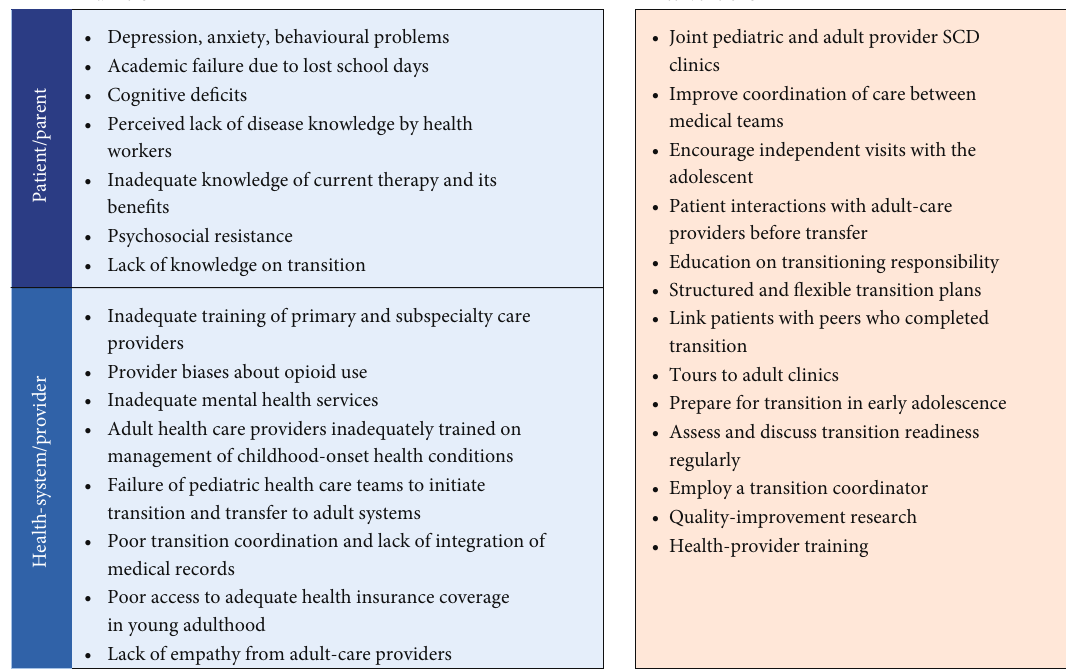
Figure 4: Barriers to adolescent-to-adult care transition and proposed